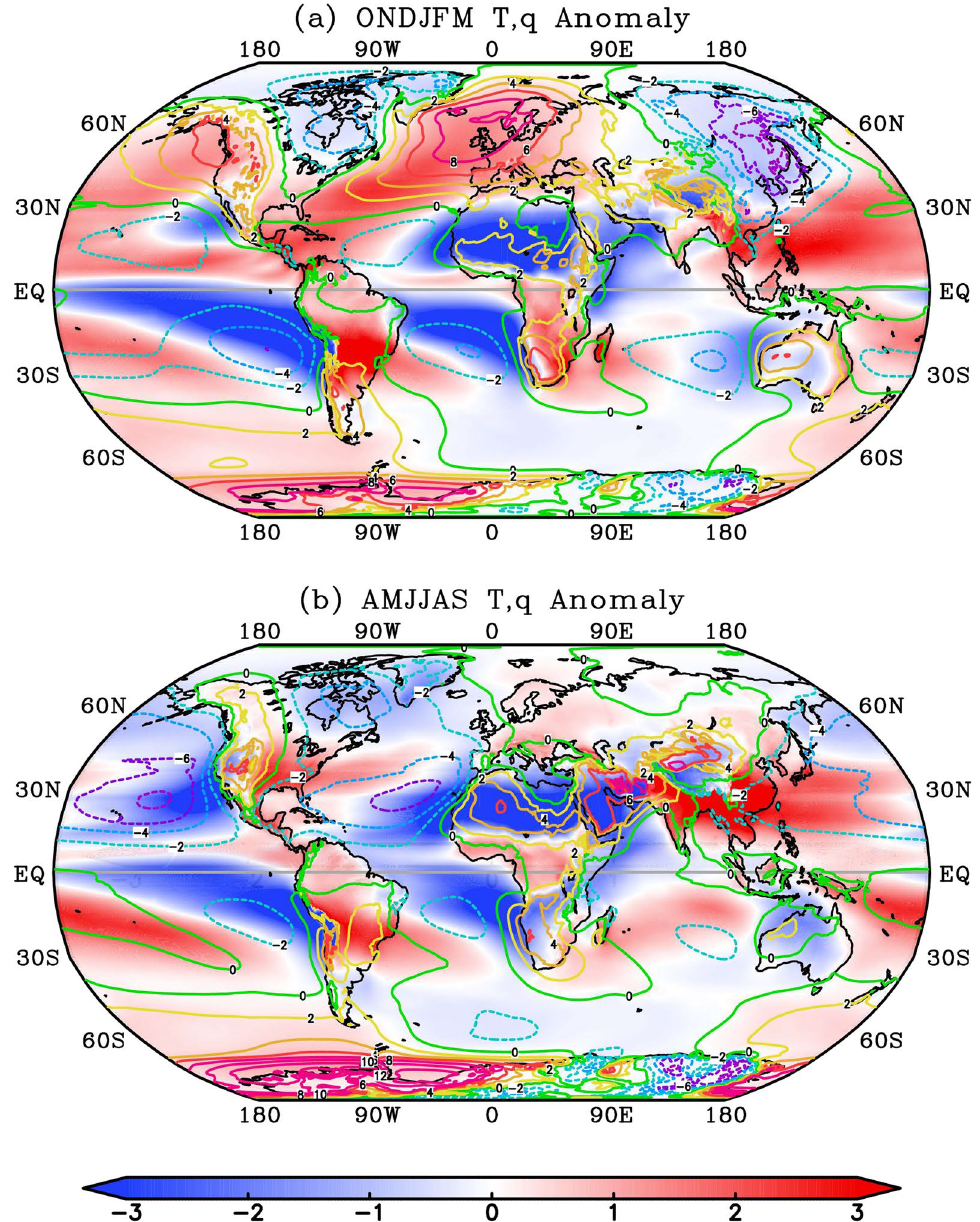
Fig. 3 Distributions of temperature (K; contour) and specific humidity (g kg − 1 ; shading) anomalies from the zonal means in the ( a ) O–M half‑year and ( b ) A–S half‑year. The contour interval is 2 K . The warm solid and cold dashed contours indicate relatively high and low temperatures, respectively. The scale of shading is shown at the bottom, and the red and blue colors indicate positive and negative anomalies, respectively of the specific